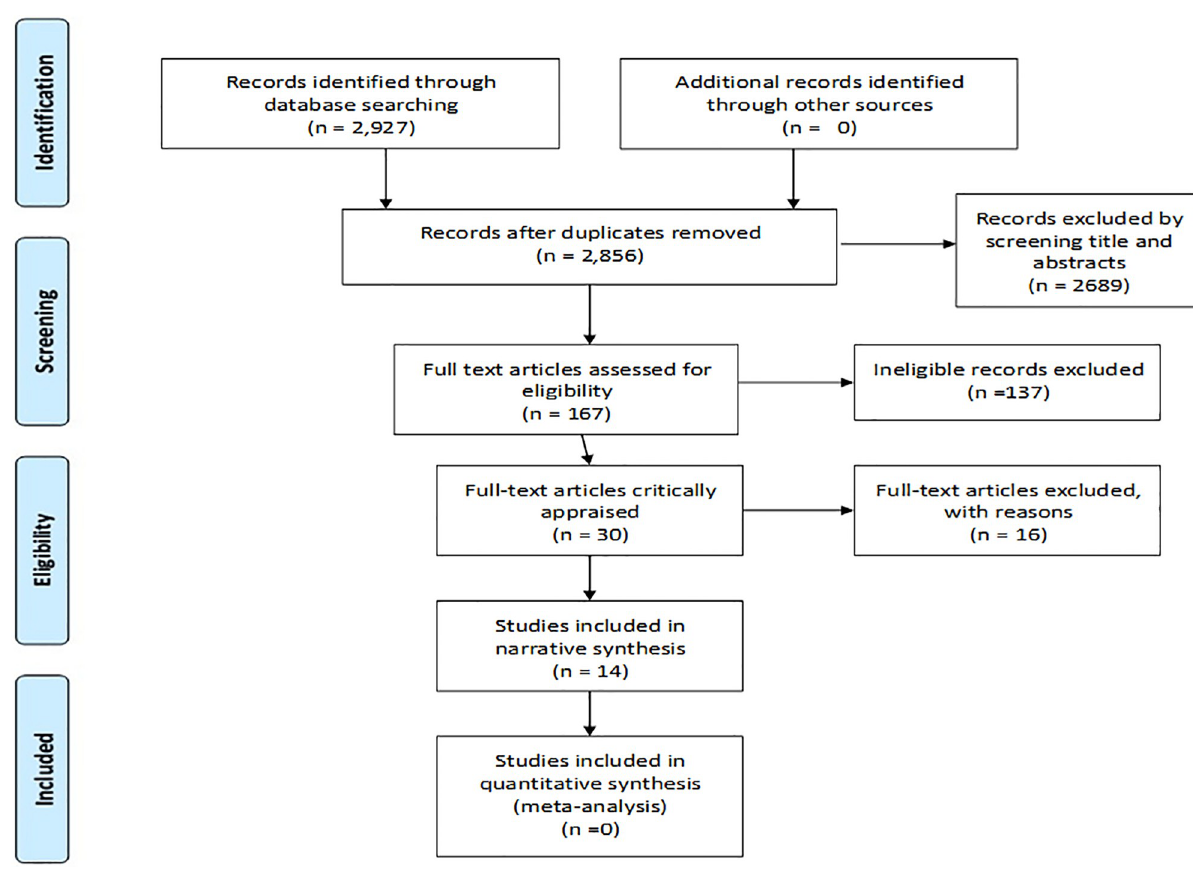
Fig 1. Study selection process. From : Moher D, Liberati A, Tetzlaff J, Altman DG, The PRISMA Group (2009). P referred R eporting I tems for S ystematic Reviews and M eta- A nalyses: The PRISMA Statement. PLoS Med 6(7): e1000097. doi:10.1371/journal.pmed1000097.